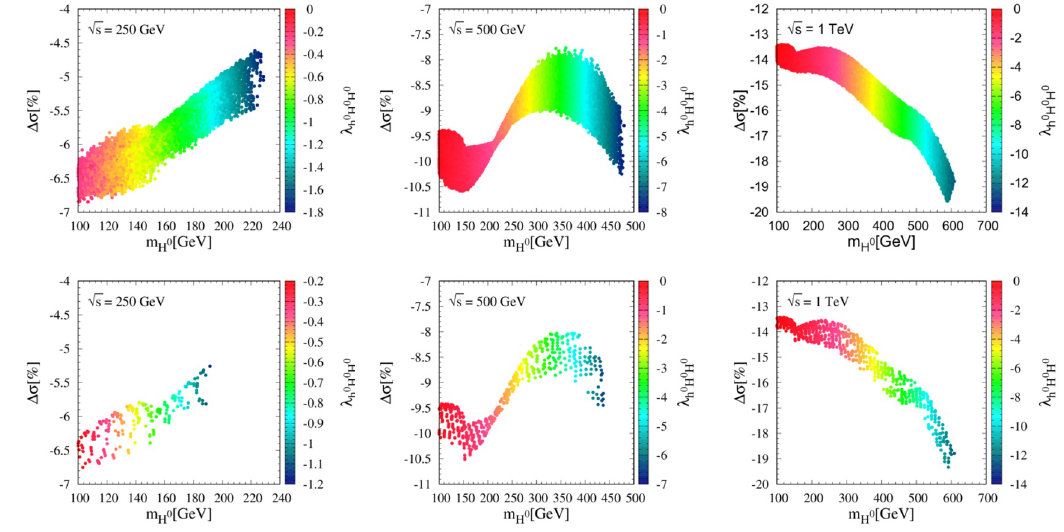
Figure 16 . In Scenario IV and V, the IHDM corrections to e + e − → H 0 A 0 as a function of Higgs masses are